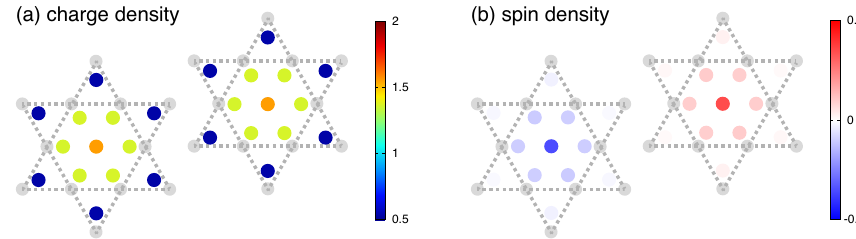
Figure 3. Charge ( a ) and spin ( b ) densities in two-hexagram unit cell in presence of both PLD ( x = − 1.5) and Coulomb interaction ( U = 3 J = 0.816eV) calculated within mean-field approximation at T = 0K. The charge–density distributions of the two hexagrams are identical, whereas their spin–density distributions have opposite